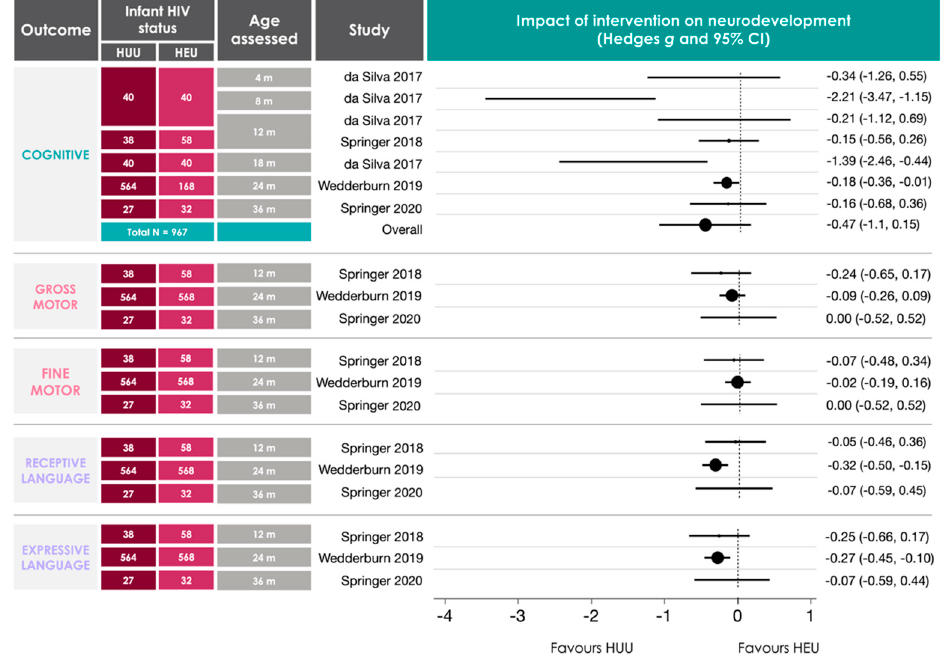
Figure 4. Random-effects meta-analysis for studies reporting on BSID-III sub-scales for infants who are HEU compared to HUU. Studies that reported means and standard deviations for scaled BSID-III scores were included. Where longitudinal data were available, analyses used the oldest data reported to capture any persistent impacts of HEU on neurodevelopment [49]. Data from da Silva et al. (2017) [41] were a cross-section of four separate groups of infants (aged 4, 8, 12, and 18 m). For one study, cognitive data analysed were composite scores, as scaled scores for this domain were not available [48]. Methodological quality assessments for these studies are reported in Figure 3. A summary effect estimate is only included for the cognitive sub-scale, as this is the only assessment that included more than five studies [30]. Data are presented in forest plots as Hedge’s g (95% CI) in ascending order according to infant age at assessment. HUU = HIV-unexposed, uninfected; HEU = HIV-exposed, uninfected; m = months; BSID-III = Bayley Scales of Infant Development 3rd edition [28]; CI = confidence interval.